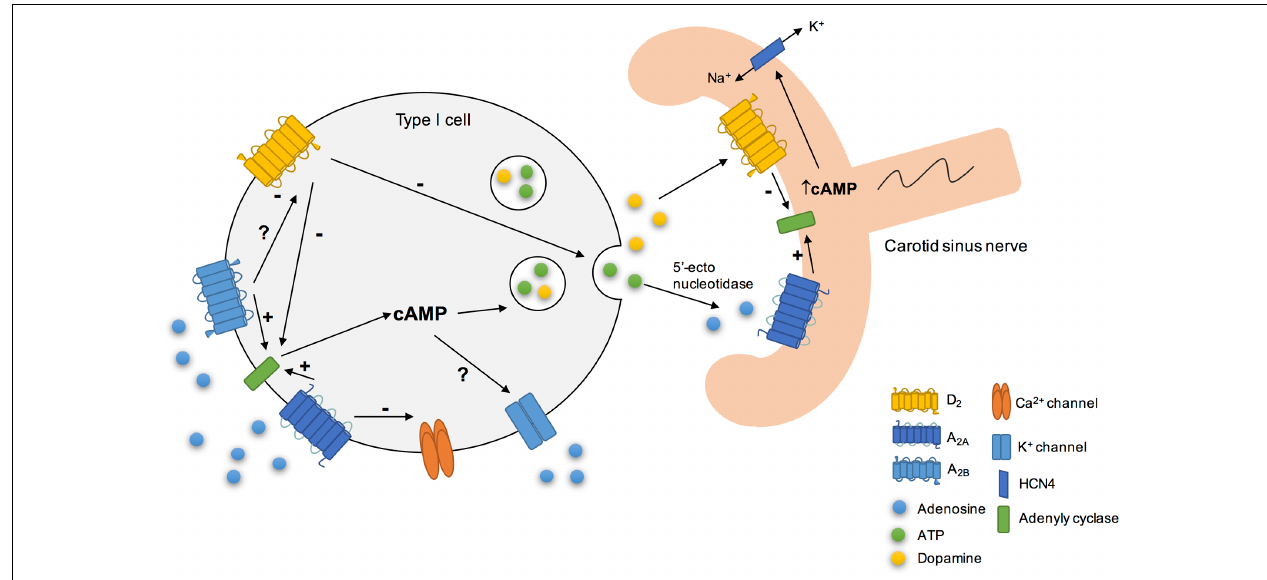
FIGURE 2 | Schematic representation of some of adenosine cellular actions on rat carotid body (CB). Adenosine increased cAMP content in type I cells via A 2A and A 2B action on adenylyl cyclase, leading to the release of neurotransmitters, as catecholamines (Conde et al., 2008). Additionally, its action on these receptors could modulate K + currents (López-López et al., 1993) for example by decreasing the amplitude of K + currents (Vandier et al., 1999) and inhibit the voltage-dependent Ca 2 + currents in type I cells. During hypoxia, adenosine released per se through the equilibrative nucleoside transport system or generated by the extracellular breakdown of ATP by 5 (cid:48) -ectonucleotidases (Conde and Monteiro, 2004; Conde et al., 2012a; Salman et al., 2017), acts postsynaptically on A 2A receptors, leading to adenylyl cyclase activation and to an increase in cAMP, which stimulates HCN4-containing non-selective cation channels that mediate I h , leading to an increase in membrane excitability. In contrast, dopamine exerts the opposite effect, leading to a decrease in petrosal membrane excitability (Zhang et al., 2017).